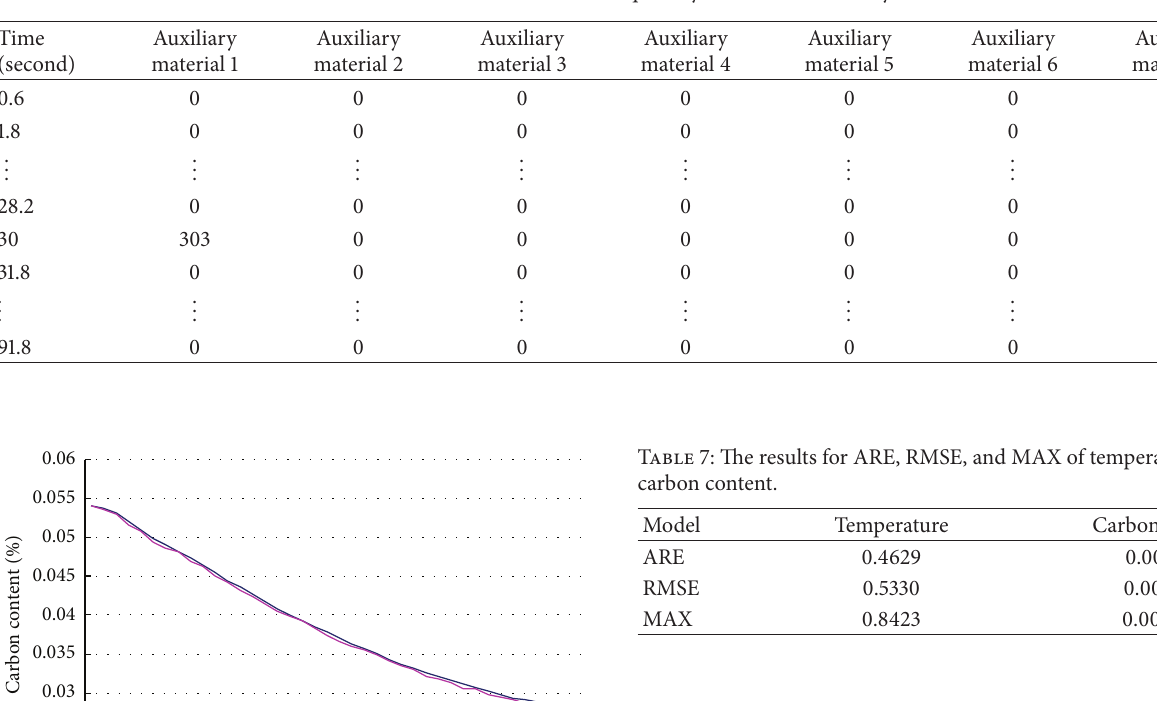
Table 6: The calculated value of addition quantity and time of auxiliary material.